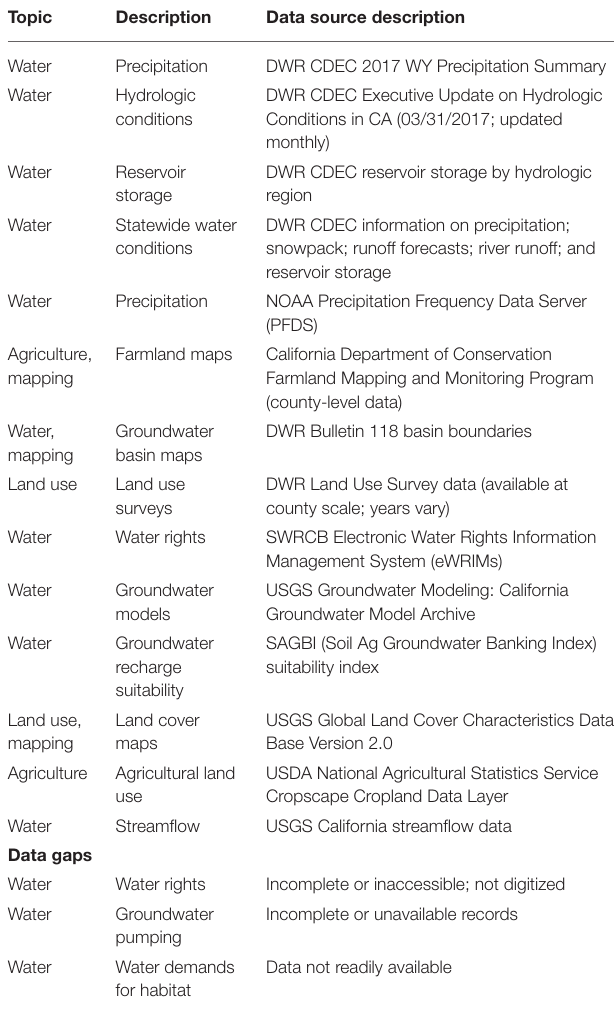
TABLE 3 | Specific data sources for groundwater recharge use